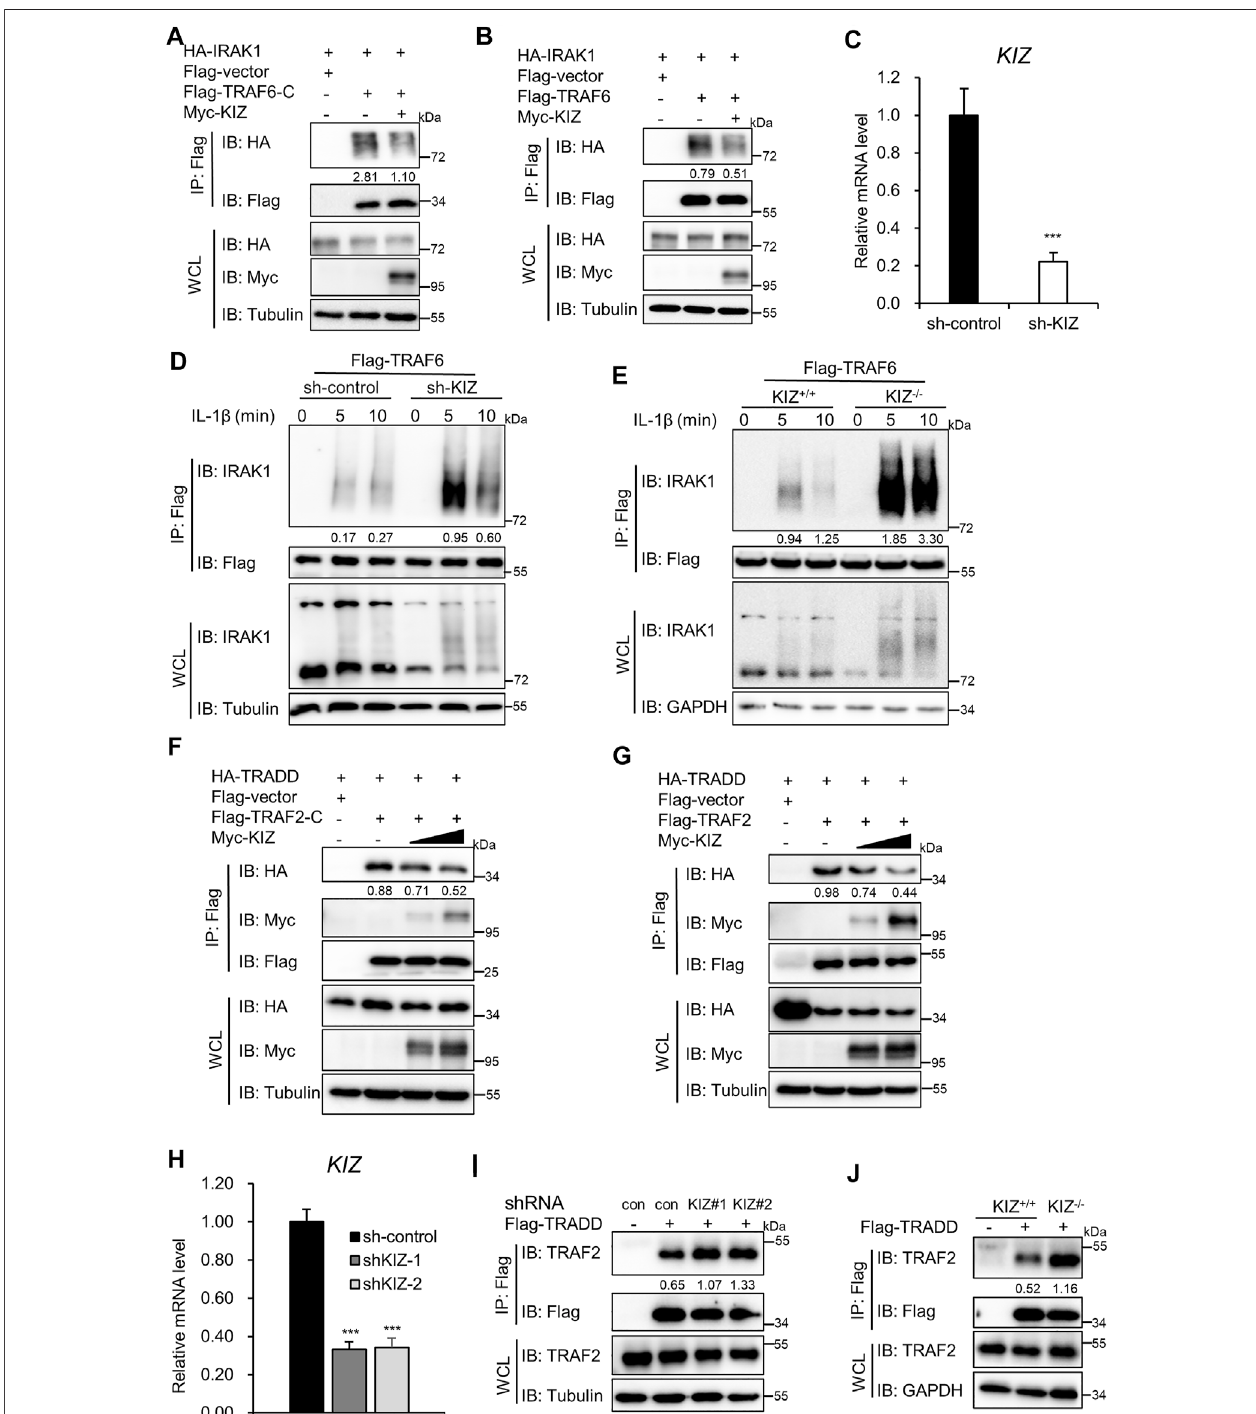
FIGURE6| KIZ antagonizes the association of TRAF2/TRAF6 with upstream adaptors. (A,B) HEK293T cells were co-transfected with the indicated plasmids. Celllysateswereimmunoprecipitatedwithanti-Flagbeads,followedbyimmunoblotting. (C,D) HEK293C6cellswereinfectedwithanshRNAlentivirusthattargeted KIZ or the empty vector for 48 h and then the cells were transfected with a Flag-tagged TRAF6 expression plasmid. After 24 h of transfection, the cells were untreated or treated with IL-1 β (5 ng/ml) for the indicated times and then lysed for qPCR to examine KIZ knockdown ef fi ciency (C) or for Co-IP with anti-Flag beads, followed by immunoblotting (D) . (E) WT and KIZ knockout HEK293 C6 cells were transfected with a Flag-tagged TRAF6 expression plasmid. After 24 h of transfection, the cells were untreated or treated with IL-1 β (5 ng/ml) for the indicated times and then lysed for Co-IP with anti-Flag beads, followed by